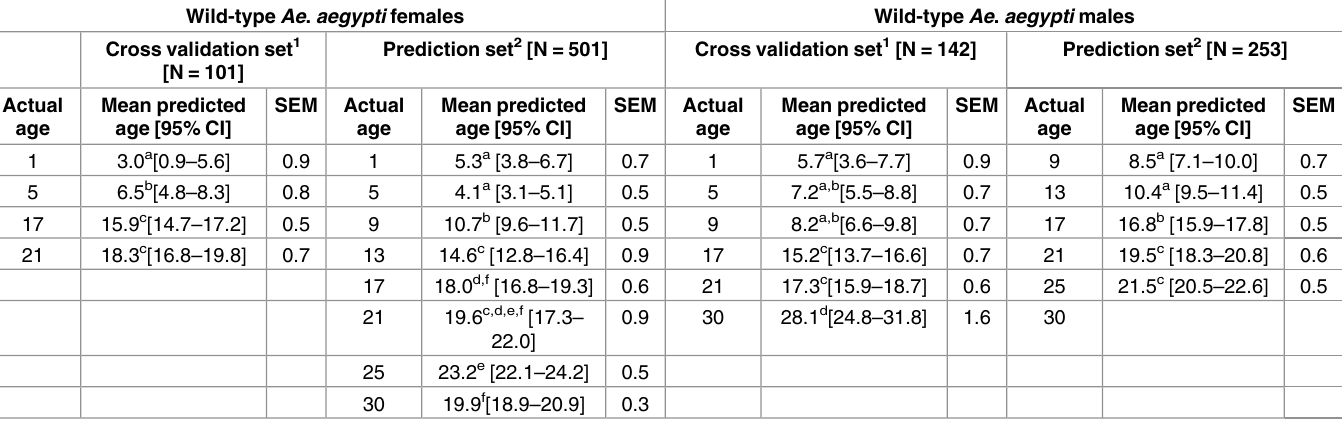
Table 1. Mean age predictions of female and male wild-type Ae . aegypti mosquitoes using the cross validation method for samples used in the model and the prediction method for samples that were excluded from the model.